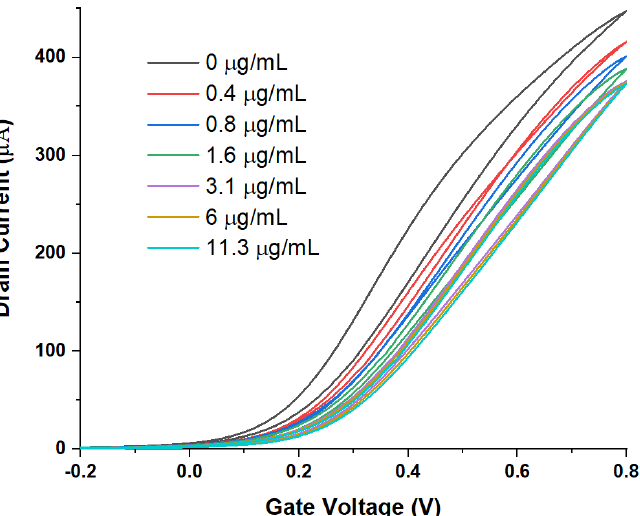
Figure 3. Transfer characteristics under increasing concentration (V D = 0.2 V). The same transfers are shown on a log I D scale in the Supplementary Materials Section S2.